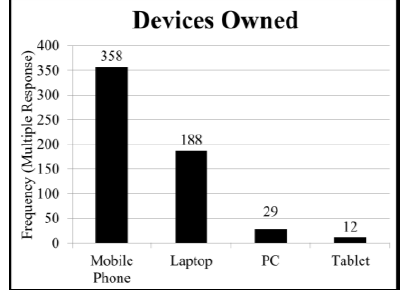
Figure 1. Devices owned by respondents (Total multiple responses = 587 out of total sample size = 365)